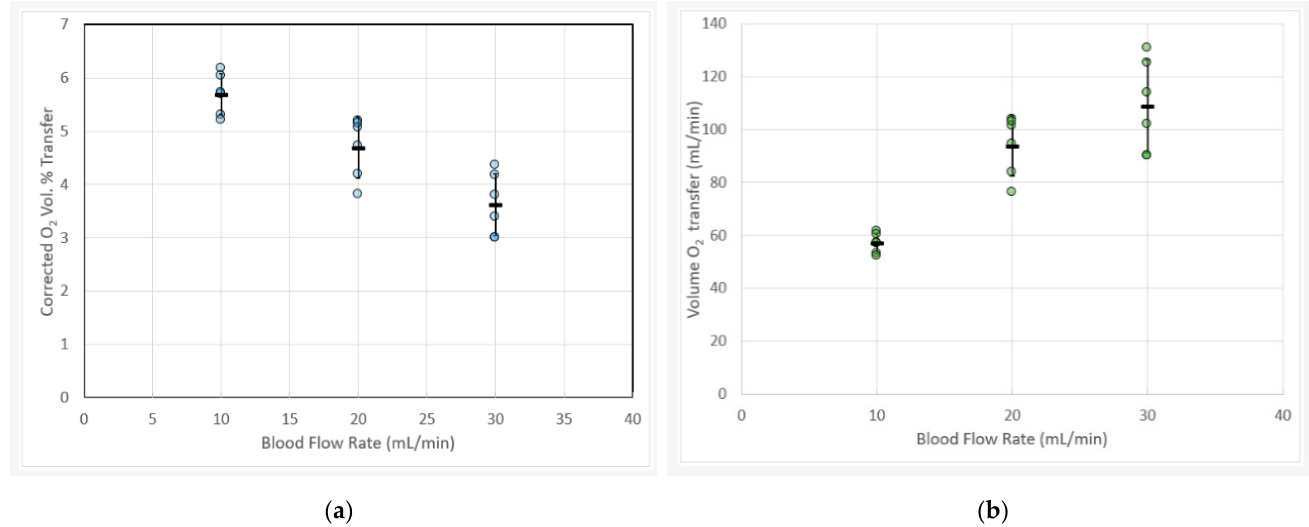
Figure 5. ( a ) Oxygen transfer rates versus blood flow rates for six RAD2v2 devices showing oxygen transfer (volume percent, defined as mL O 2 /min divided by blood flow rate (mL/min) corrected for hemoglobin and STP.) At each blood flow rate, each device was tested three times and the average recorded. The standard deviation reflects the variation between the six devices tested. Note that the volume percent at 30 mL/min blood flow corresponds to an increase in oxygen saturation from 75 to 95%. ( b ) Data from Figure 5a plotted as volume rate of oxygen transfer versus blood flow rate.